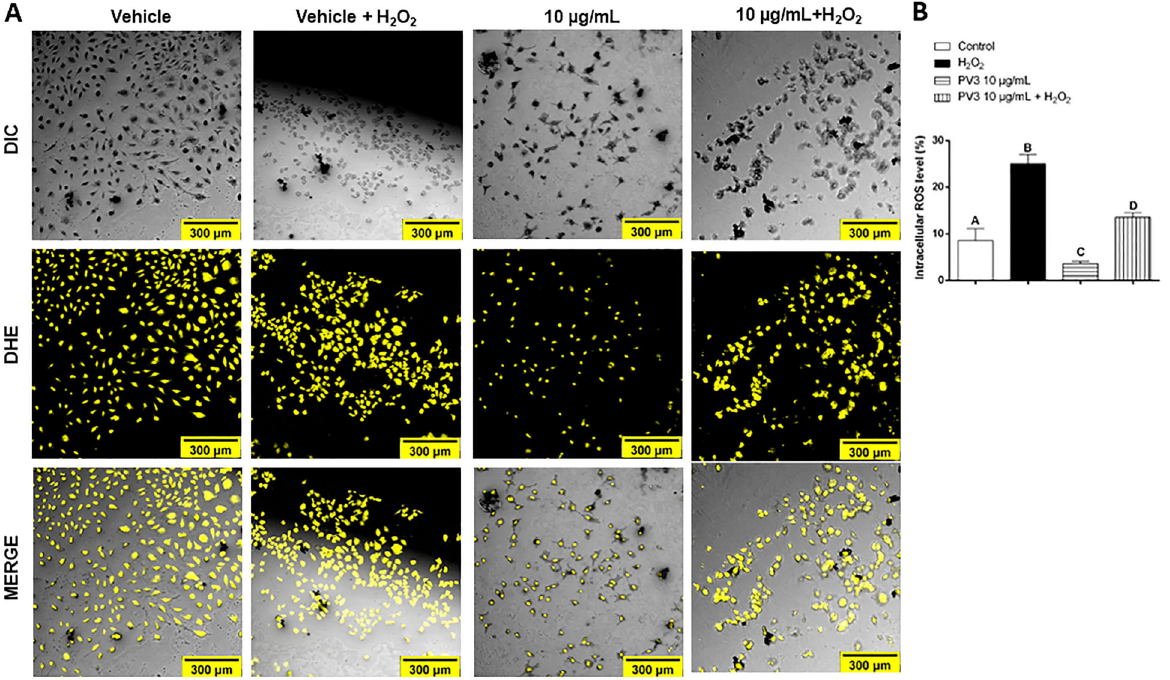
Figure 3. A , Confocal microscopy and DHE probe analysis of the effect of H 2 O 2 and Phaseolus vulgaris peptide (PV3) on reactive oxygen species (ROS) (scale bar 300 m m). B , Quanti fi cation of pixels generated from the speci fi c excitation of ROS molecules The data are reported as means ± SE. P o 0.05, different upper-case letters indicate that all groups differed from each other (ANOVA and Fisher